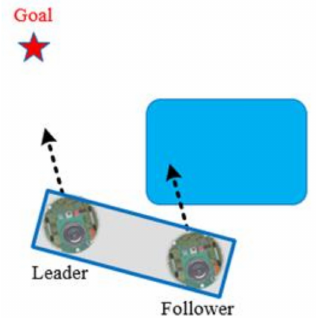
Figure 20. Follower detects the obstacle.